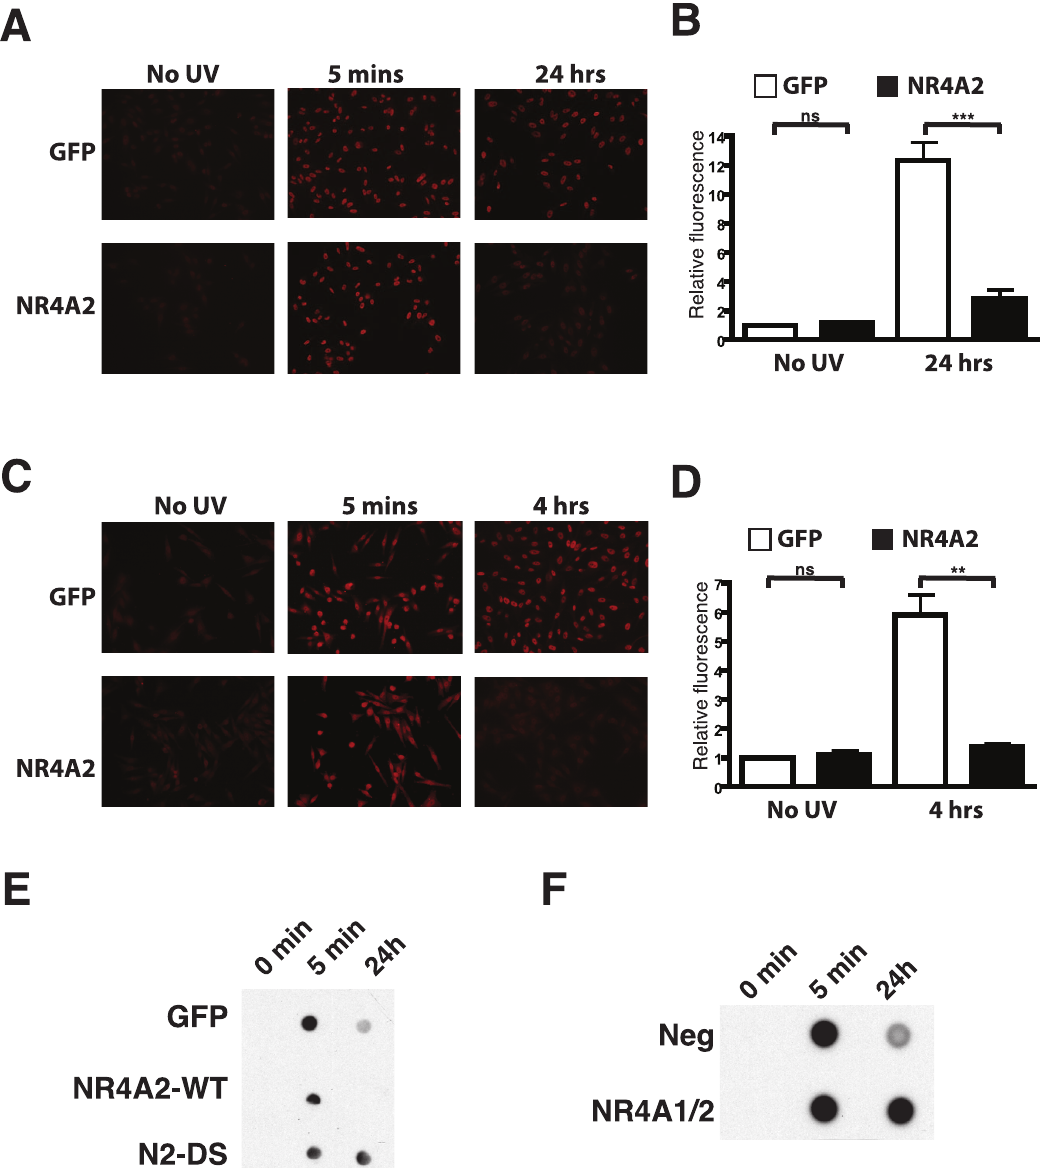
Figure 7. NR4A2 expression facilitates removal of UVR induced DNA lesions. ( A ) A2058 melanoma cell lines engineered to stably express either GFP or NR4A2 were subjected to mock or UVR treatment after which the levels of CPD’s were determined by immunofluorescence 24 hours post irradiation. Representative images are shown. ( B ) Quantification of CPD fluorescence of multiple images from three independent experiments is shown with values normalised to the A2058-GFP mock treated cells. Data is expressed as the mean + / 2 SEM of 3 independent experiments. ( C ) A2058-GFP and A2058-NR4A2 cells were treated as described above and 6-4-PP levels determined by immunofluorescence at 4 hours post irradiation. Representative images are shown. ( D ) Quantification of 6-4-PP fluorescence was performed as described above for the mock (no UV) and 4 hour post UVR conditions. Data is expressed as the mean + / 2 SEM of 3 independent experiments. (E) South-western blot analysis of CPD levels in A2058 cells stably expressing GFP, NR4A2-WT or N2-DS proteins following UVR treatment. (F) South-western blot analysis of CPD levels in MM96L cells, transfected with negative or pooled NR4A2 and NR4A1 siRNAs as indicated, following UVR treatment. In panels E and F, total genomic DNA was harvested prior to irradiation (0 min) and 5 minutes and 24 hours post irradiation as